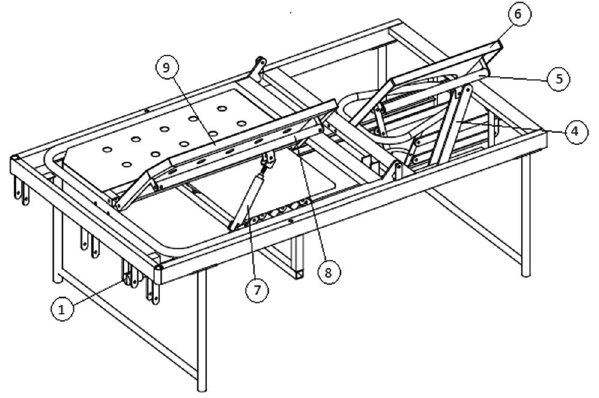
Fig. 8 Side in the raised position. (1: Screw, 4: Link, 5: Shaft, 6: Hip- rest, 7: Link, 8: Telescopic link, 9: Backrest)